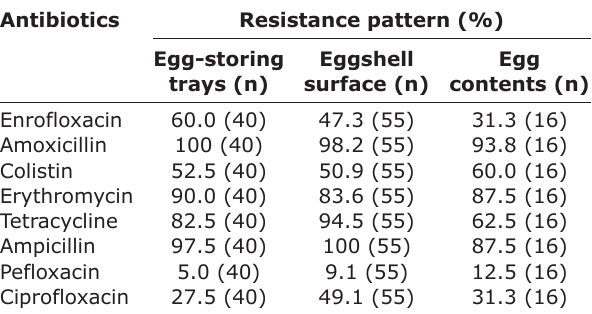
Table-2: Antimicrobial resistance pattern of Salmonella isolates from egg-storing trays, eggshell surface, and